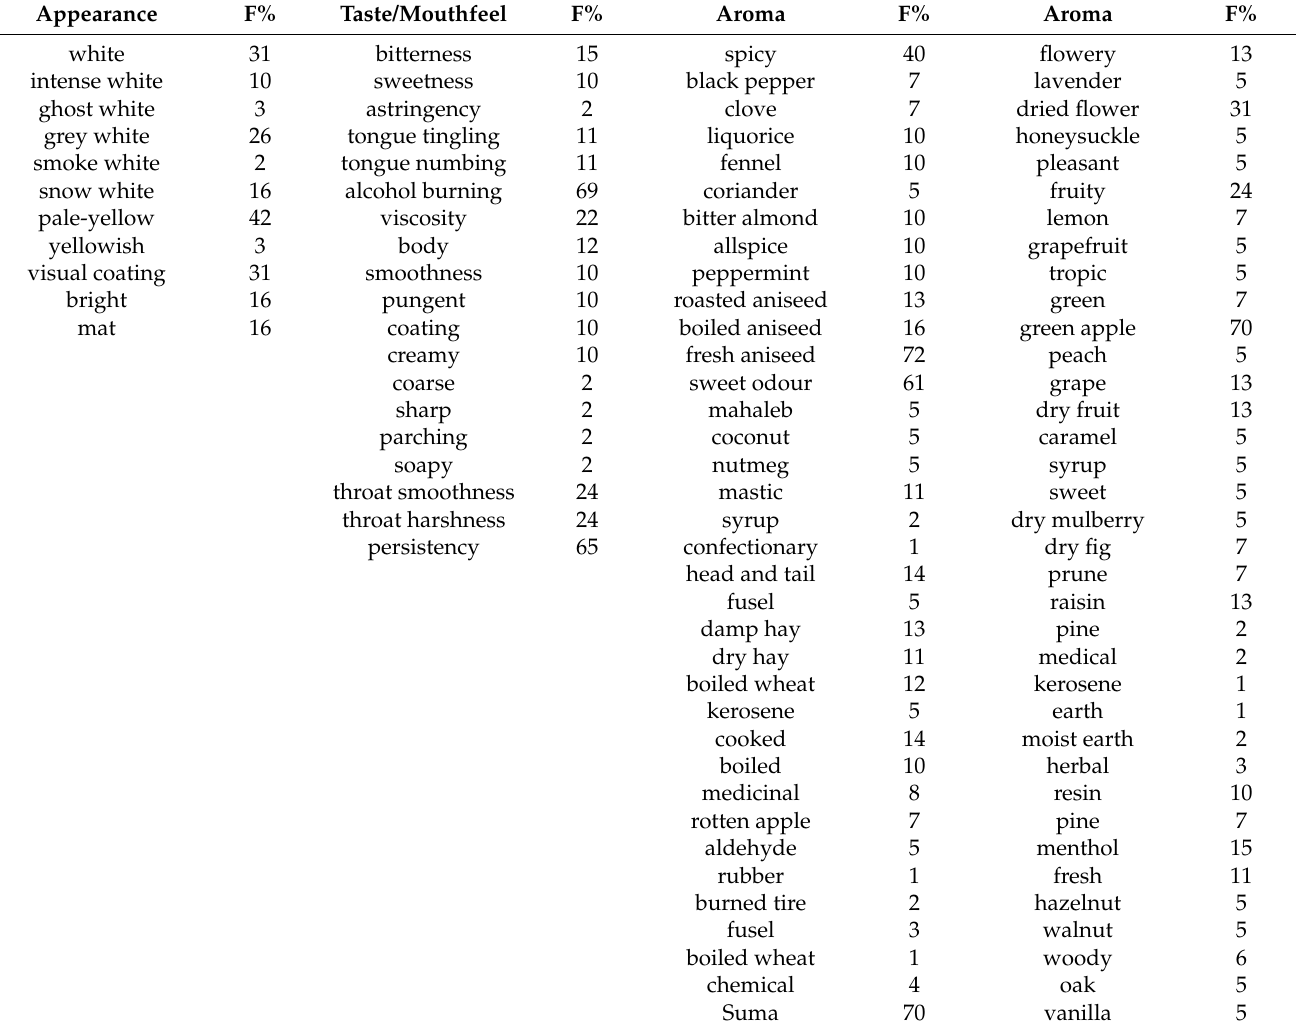
Table 3. Preliminary list of descriptive terms generated during the expert panel for Rakı samples and their frequency of use. Appearance